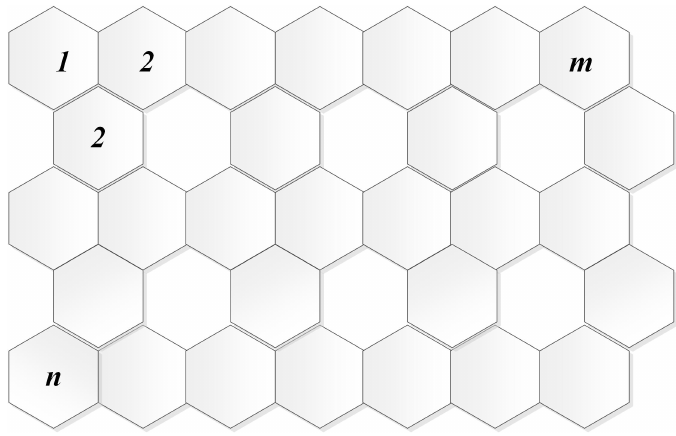
Fig. 1 2-Dimensional graph of graphene